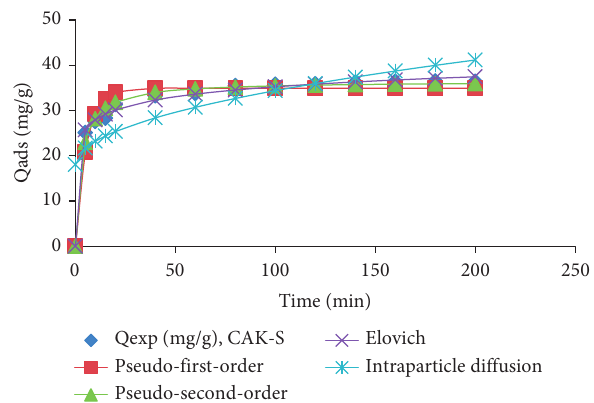
Figure 6: Nonlinear plot of kinetic models of R adsorption by